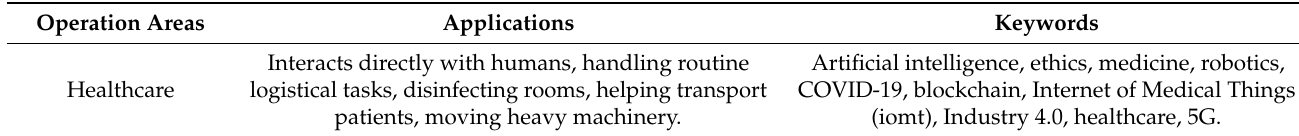
Table 1. Operation areas, applications, and keywords related to service